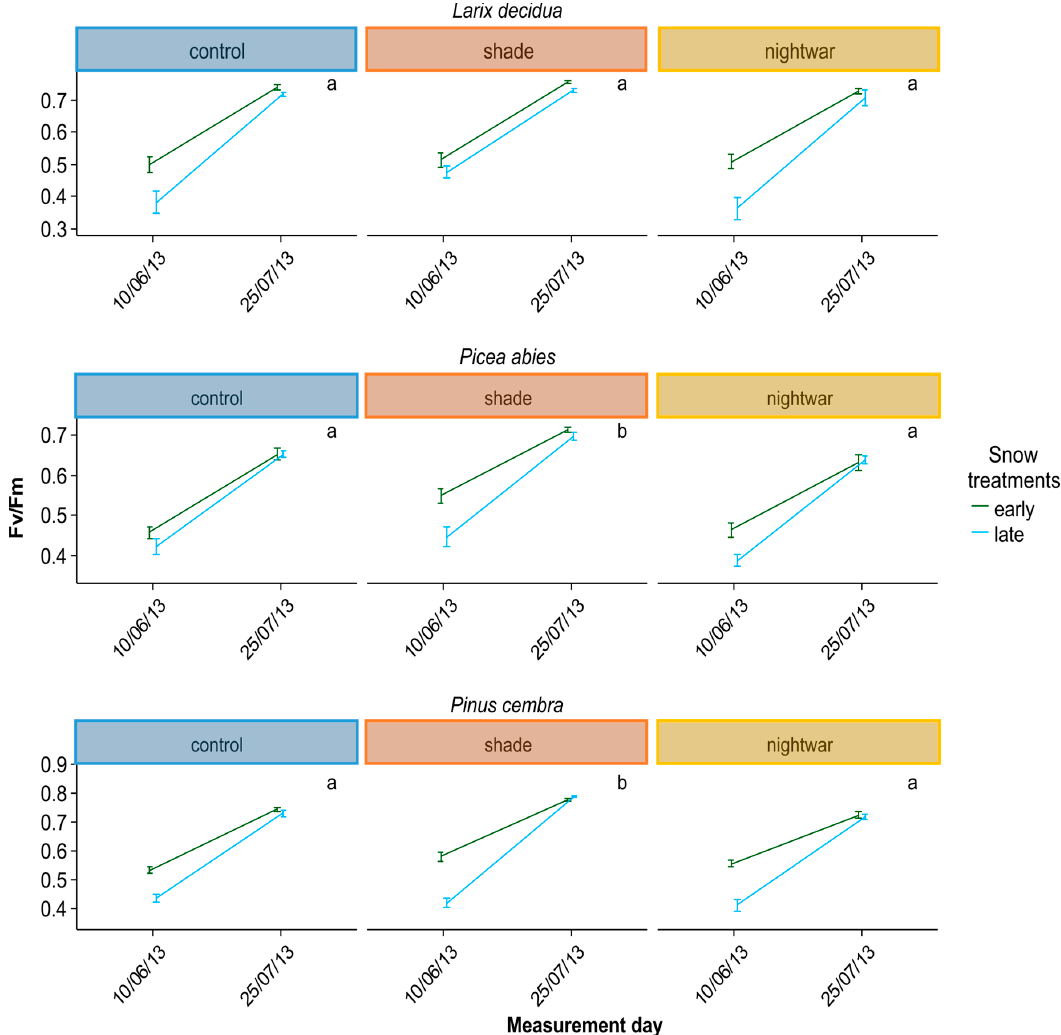
Figure A2. Pre-dawn quantum yield (chlorophyll fluorescence parameter Fv/Fm) of tree seedlings near the treeline in the French Alps, planted autumn 2012. Line colors indicate snowmelt treatments (early and late, legend). Columns correspond to sky-exposure treatments: control (no roof), shade (shade roof during the day), and nightwar = night warming (shade roof during the night). Shown are mean values (±se) based on eight to 20 individuals per treatment combination (in four blocks). Shade had significantly higher Fv/Fm overall (Tukey HSD post-hoc test, p < 0.001), while the effect of the snow treatment differed between measurement dates ( p < 0.001).